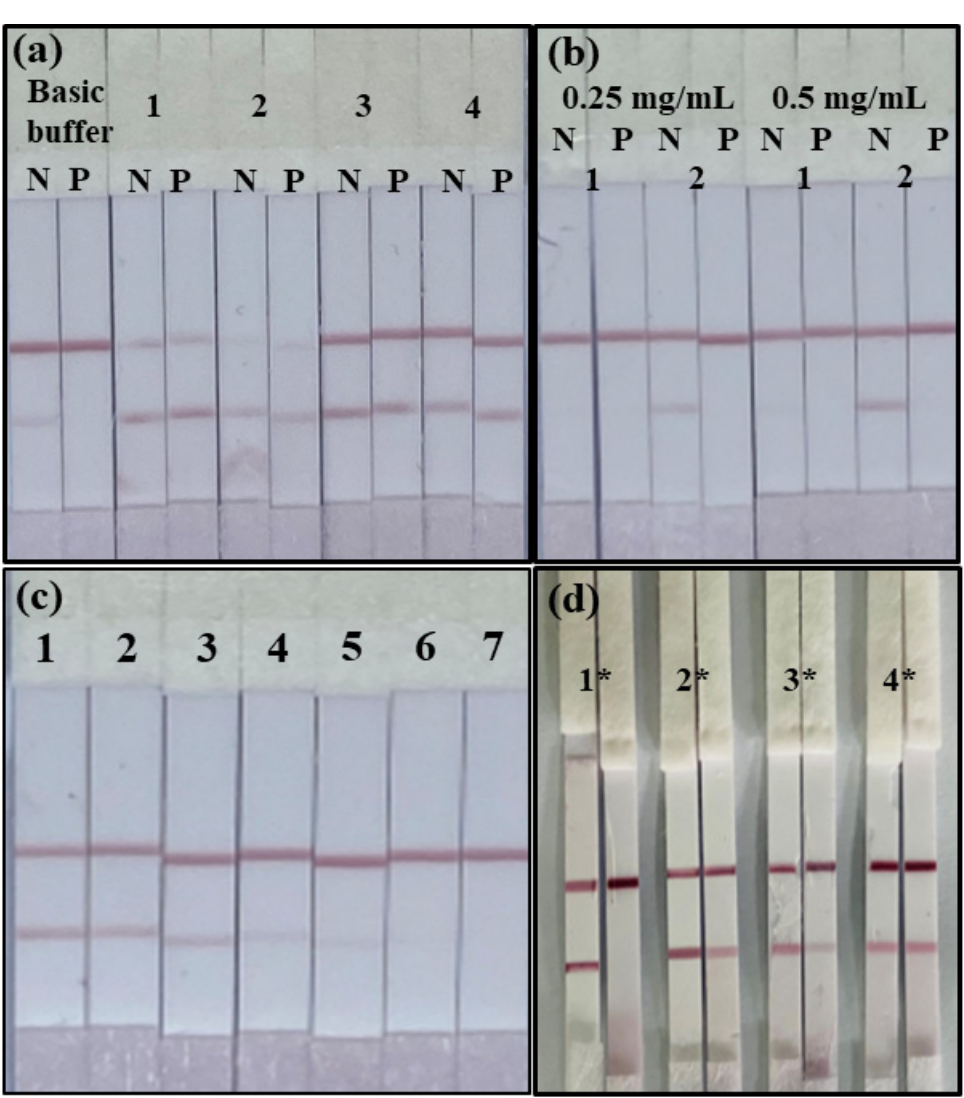
Figure 5. ICA strip performance and applied in the spike and true samples. ( a ) ICA strip with different running basic buffer and 1, 2, 3, 4, which represent 5% PVP, 5% On-870, 5% BSA, 5% PEG respectively (N, 0 ng mL − 1 ; P, 20 ng mL − 1 of mercury). ( b ) The optimization of the antigen and the colloidal gold-mAb concentration (1, 5 µg mL − 1 mAb; 2, 10 µg mL − 1 ; N, 0 ng mL − 1 ; P, 20 ng mL − 1 of mercury). ( c ) The numbers (1, 2, 3, 4, 5, 6, 7 represent 0, 10, 20, 50, 100, 200, 500 ng mL − 1 , respectively. ( d ) Sample analysis with ICA strips ( n = 4). (1*, 2*, 3*, 4*) are four real samples of rice purchased from the National Reference Materials Centre.